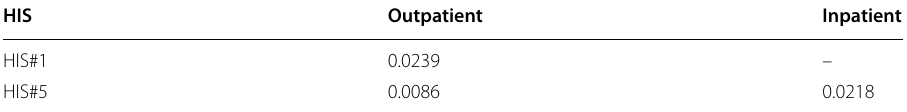
Table 6 Comparison of EHR structure indices by outpatient and inpatient clinics